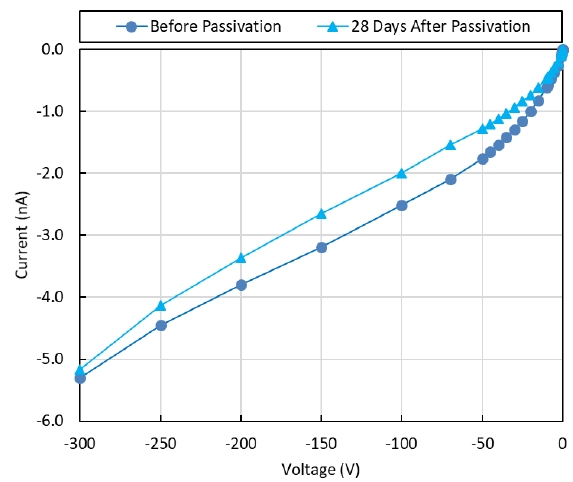
Figure 6. The applied voltages for the CZTS detector were selected from the negative bias range where the absolute values of the currents were lower than pre-passivation values.